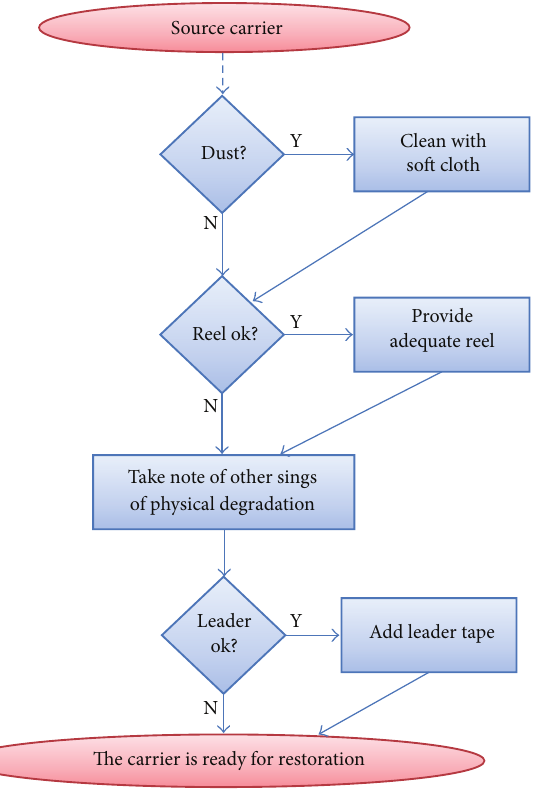
Figure 4: Flowchart of the step 1.2 preparation of the carrier → visual